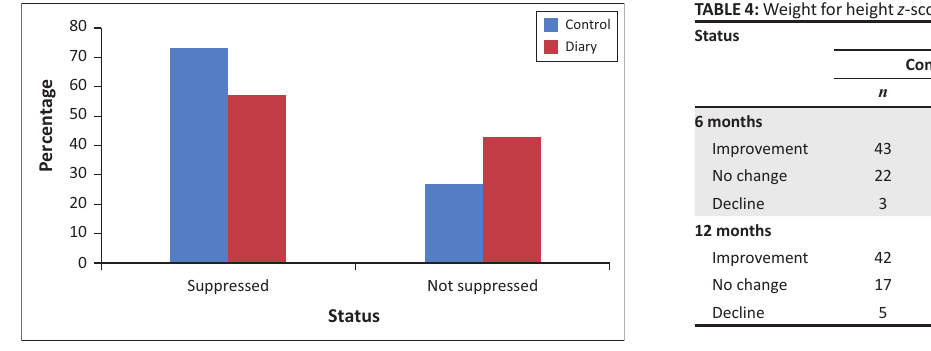
FIGURE 2: Viral load response at 12 months for both groups. TABLE 3: CD4+ % response at 6 and 12 months for both groups.